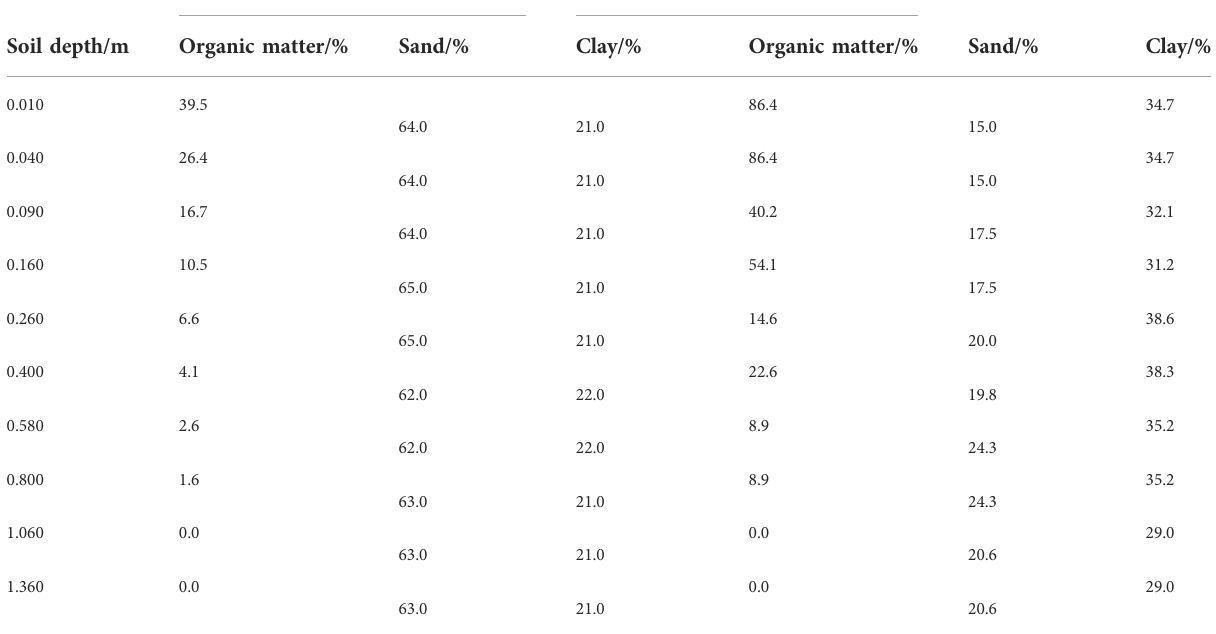
TABLE 2 Modi fi cation of soil properties at Pailong